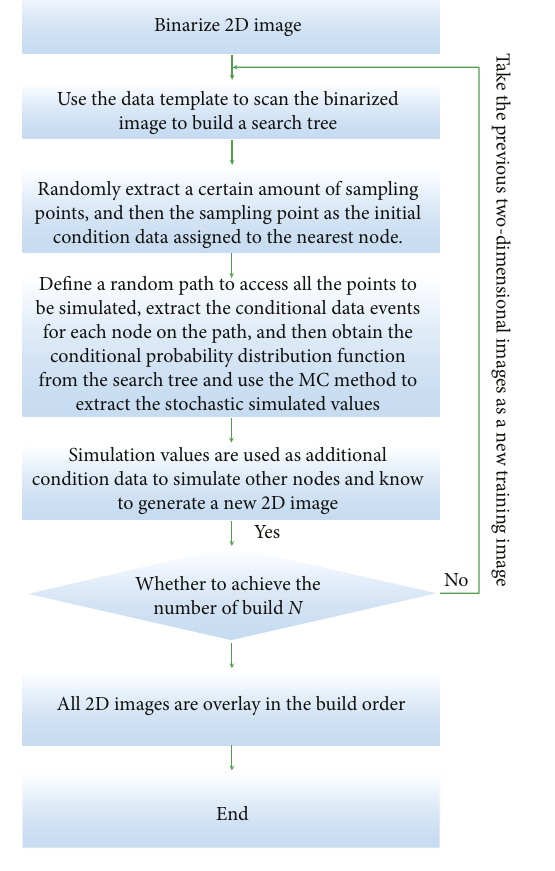
Figure 10: MPS reconstruction method fl ow chart.